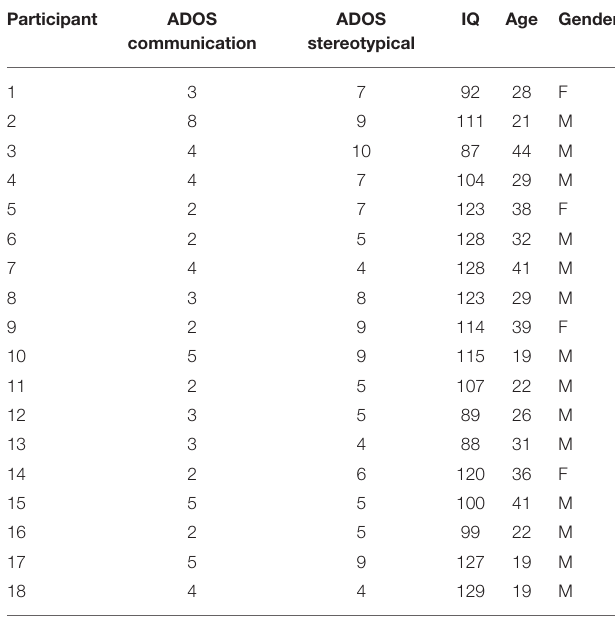
TABLE 3 | Demographic information for the autism